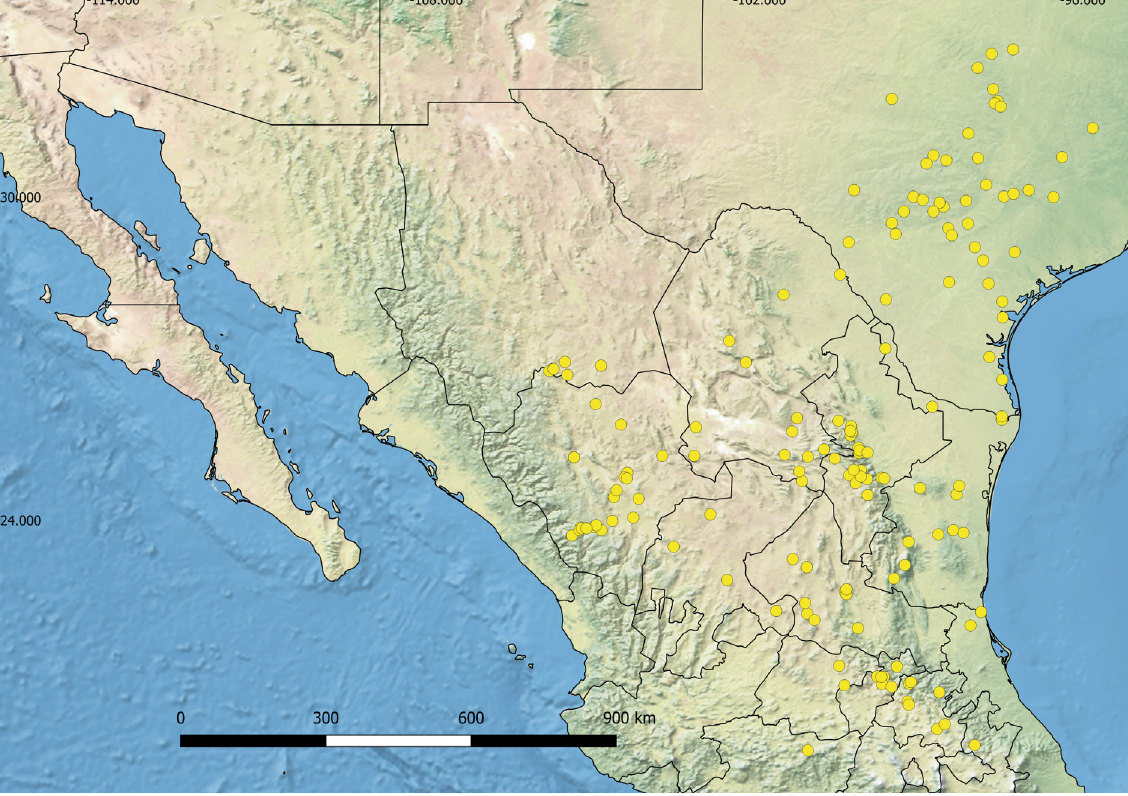
Fig. 8. Locality records of Salvadora lineata